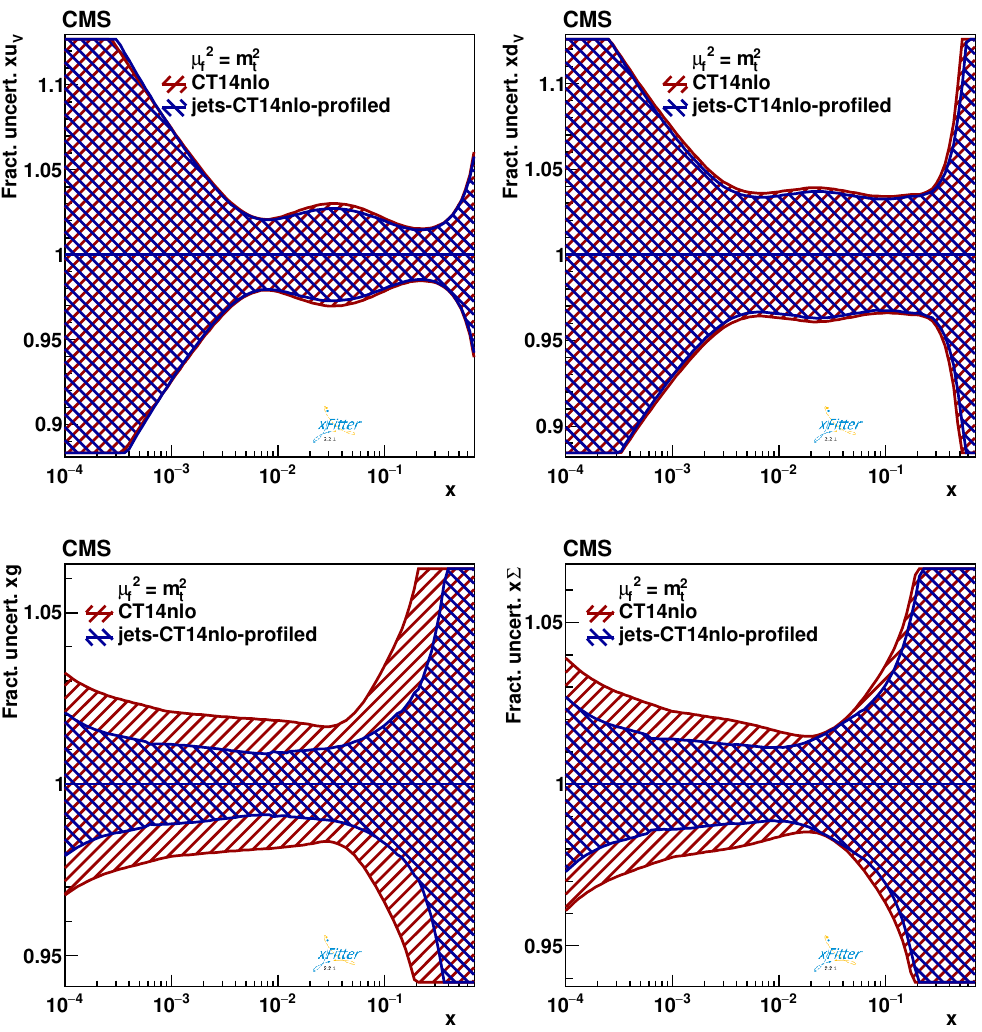
Figure 9 . Fractional uncertainties in the u -valence (upper left), d -valence (upper right), gluon (lower left), and the sea quark (lower right) distributions, shown as a function of x for the scale = m . The profiling is performed using CT14nlo PDF at NLO, by using CMS inclusive jet µ f t √ cross section at s = 13 TeV, implying the theoretical prediction for these data at NLO+NLL. The original uncertainty is shown in red, while the profiled result is shown in blue.